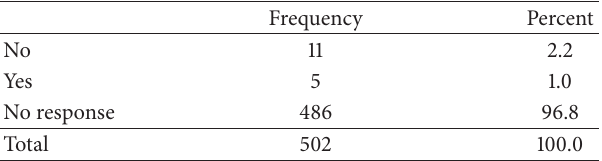
Table 5: Malaria occurrence after spraying and without using net.